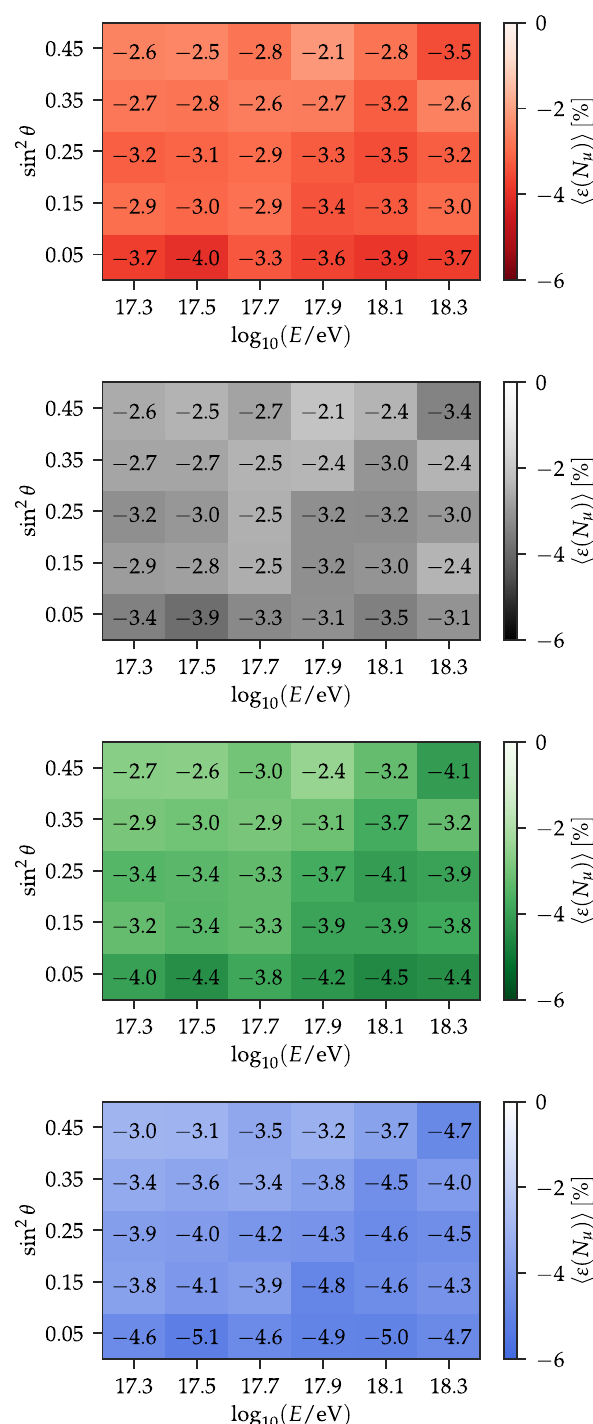
Fig. 12 Mean ε as a function of the logarithmic energy and the sine square of the zenith angle, for the 1-bin (top), the infinite window (sec- ond to top), the N-bin centered (second to bottom), and the N-bin (bot- tom) strategies. We use proton showers in an hexagonal array with distance cuts. The distance distribution is that of Fig.